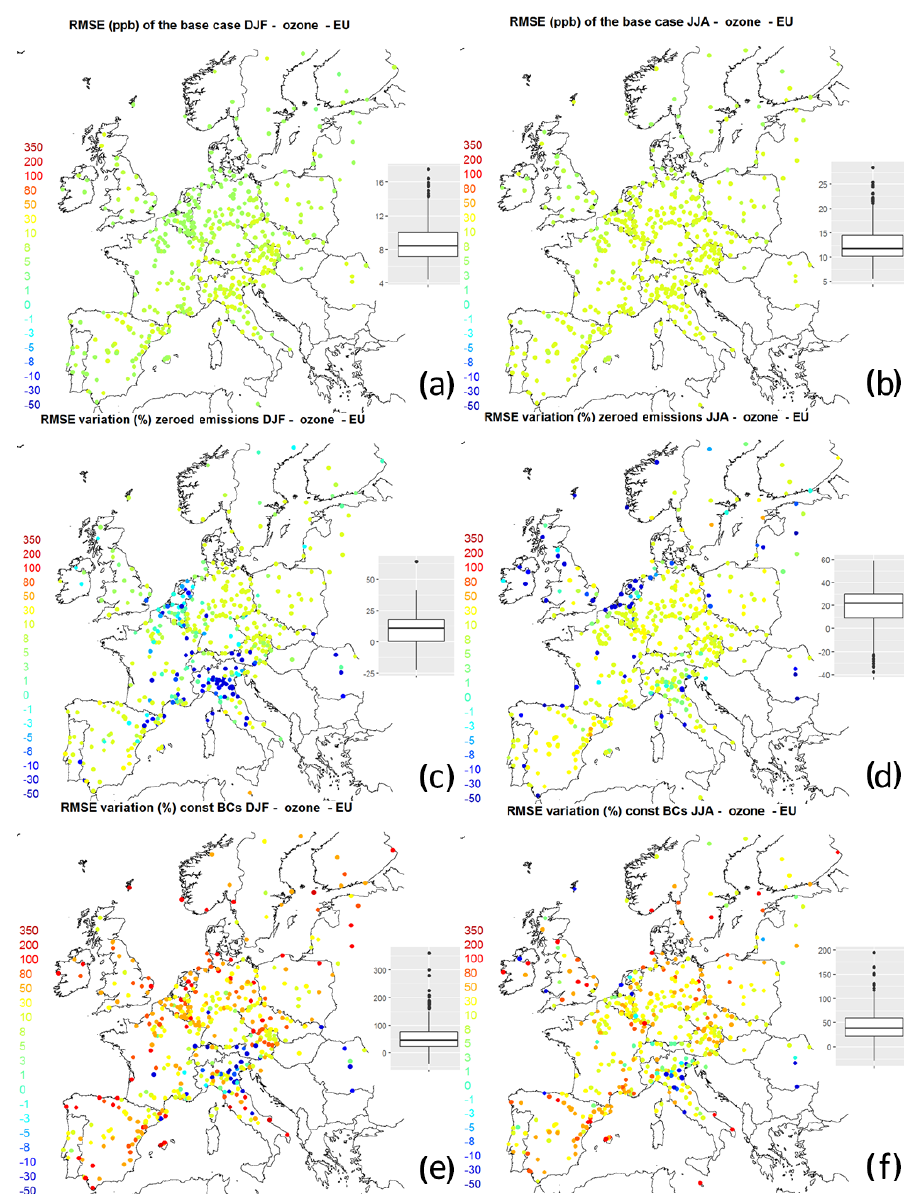
Figure 17. (a, b) Spatial maps of RMSE (in ppb) for the base case. (c, d) Percentage RMSE changes for the zeroed emissions case with respect to the base case. (e, f) Percentage RMSE changes for the constant boundary condition case with respect to the base case. (a, c, e) Winter months (DJF); (b, d, f) summer months